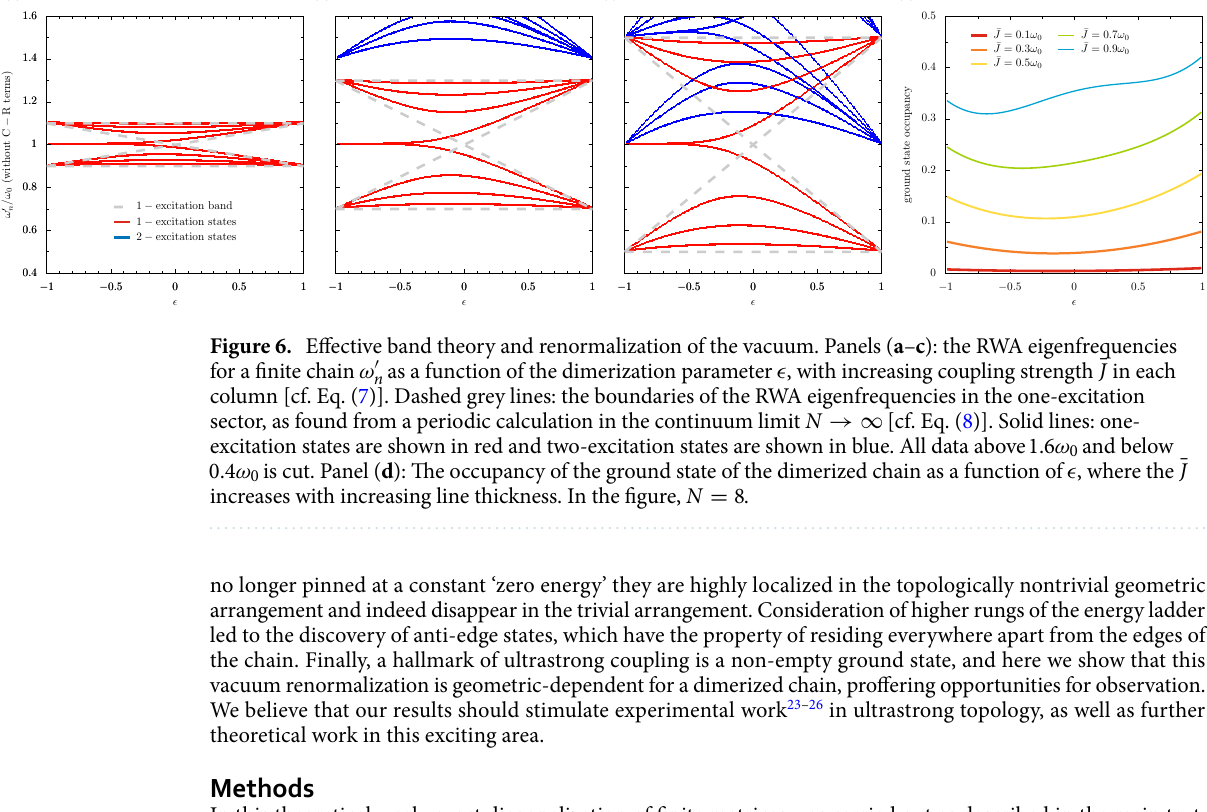
[cf. Eq. (8)]. Solid lines: one- → ∞ J ¯ 8 =